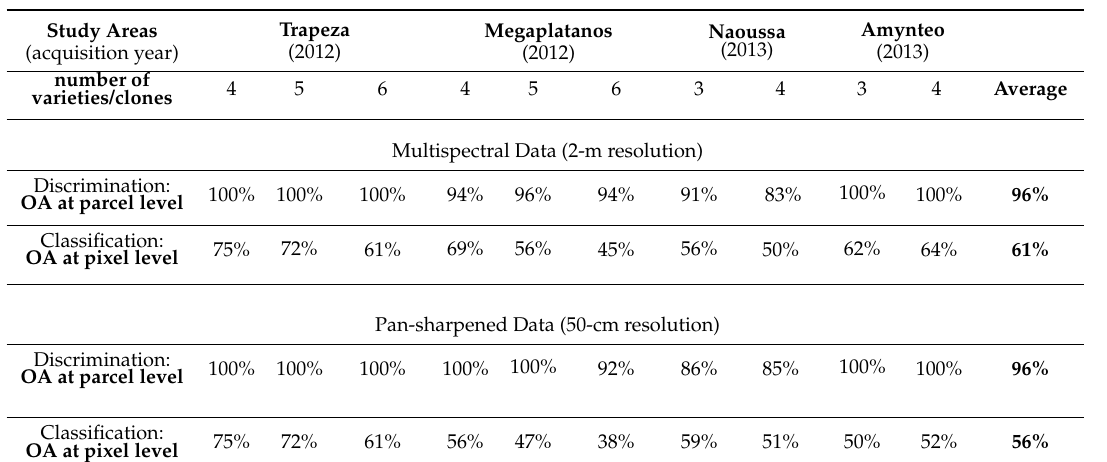
Quantitative evaluation results after the application of the developed vine variety discrimination